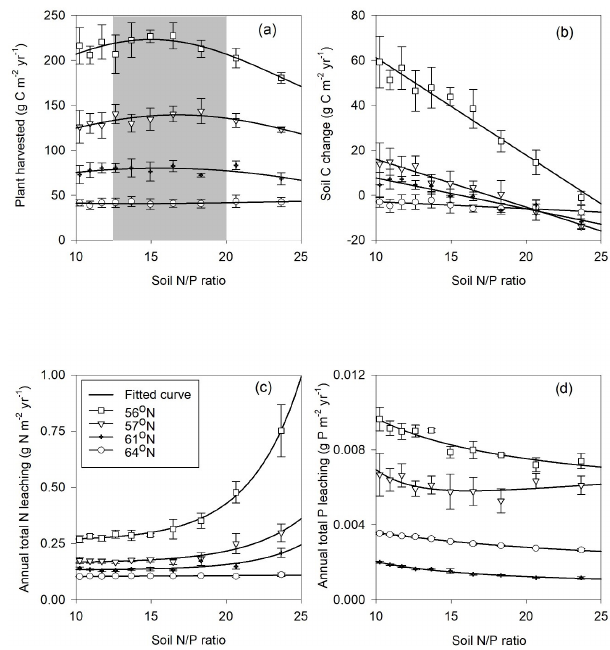
Figure 5. Simulated annual mean (a) harvested biomass, (b) soil C change (positive values denote sequestration, negative values denote losses), (c) total N leaching, and (d) total P leaching in response to changes in soil organic N / P ratio across the four regions. The bars demonstrate the standard deviation of a mean value based on changes in shortcut uptake rates of N and P (see Table